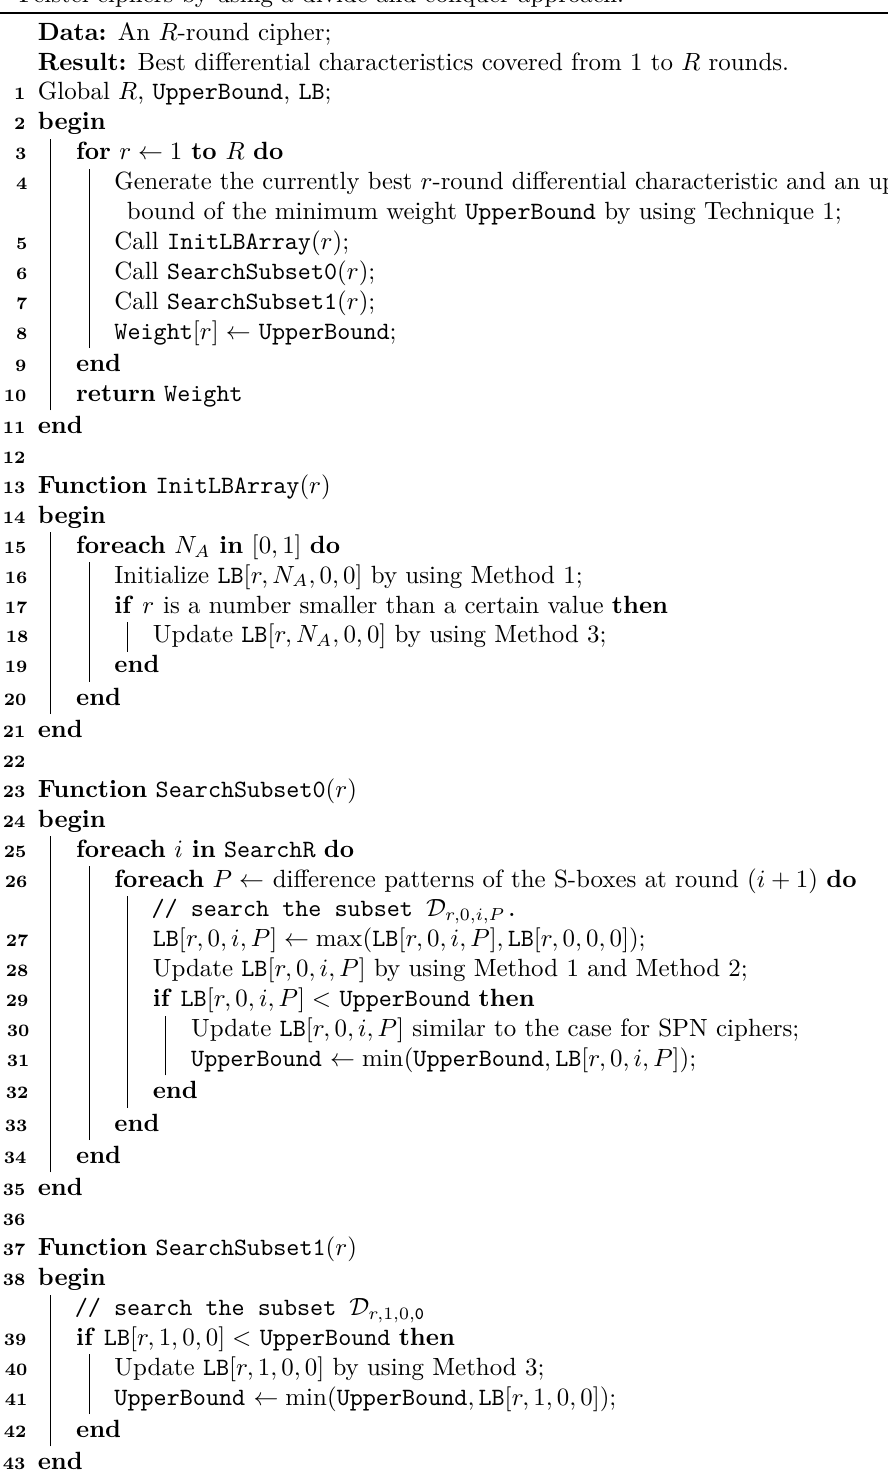
Algorithm 2: Process of searching for the best differential characteristic for Feistel ciphers by using a divide-and-conquer